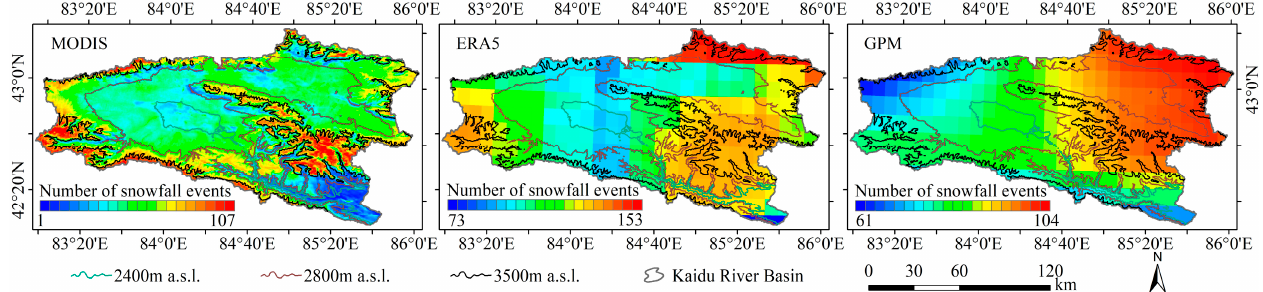
Figure 16. The average frequency of snowfall over the KRB derived by MODIS, ERA5, and GPM datasets from June 2000 to May